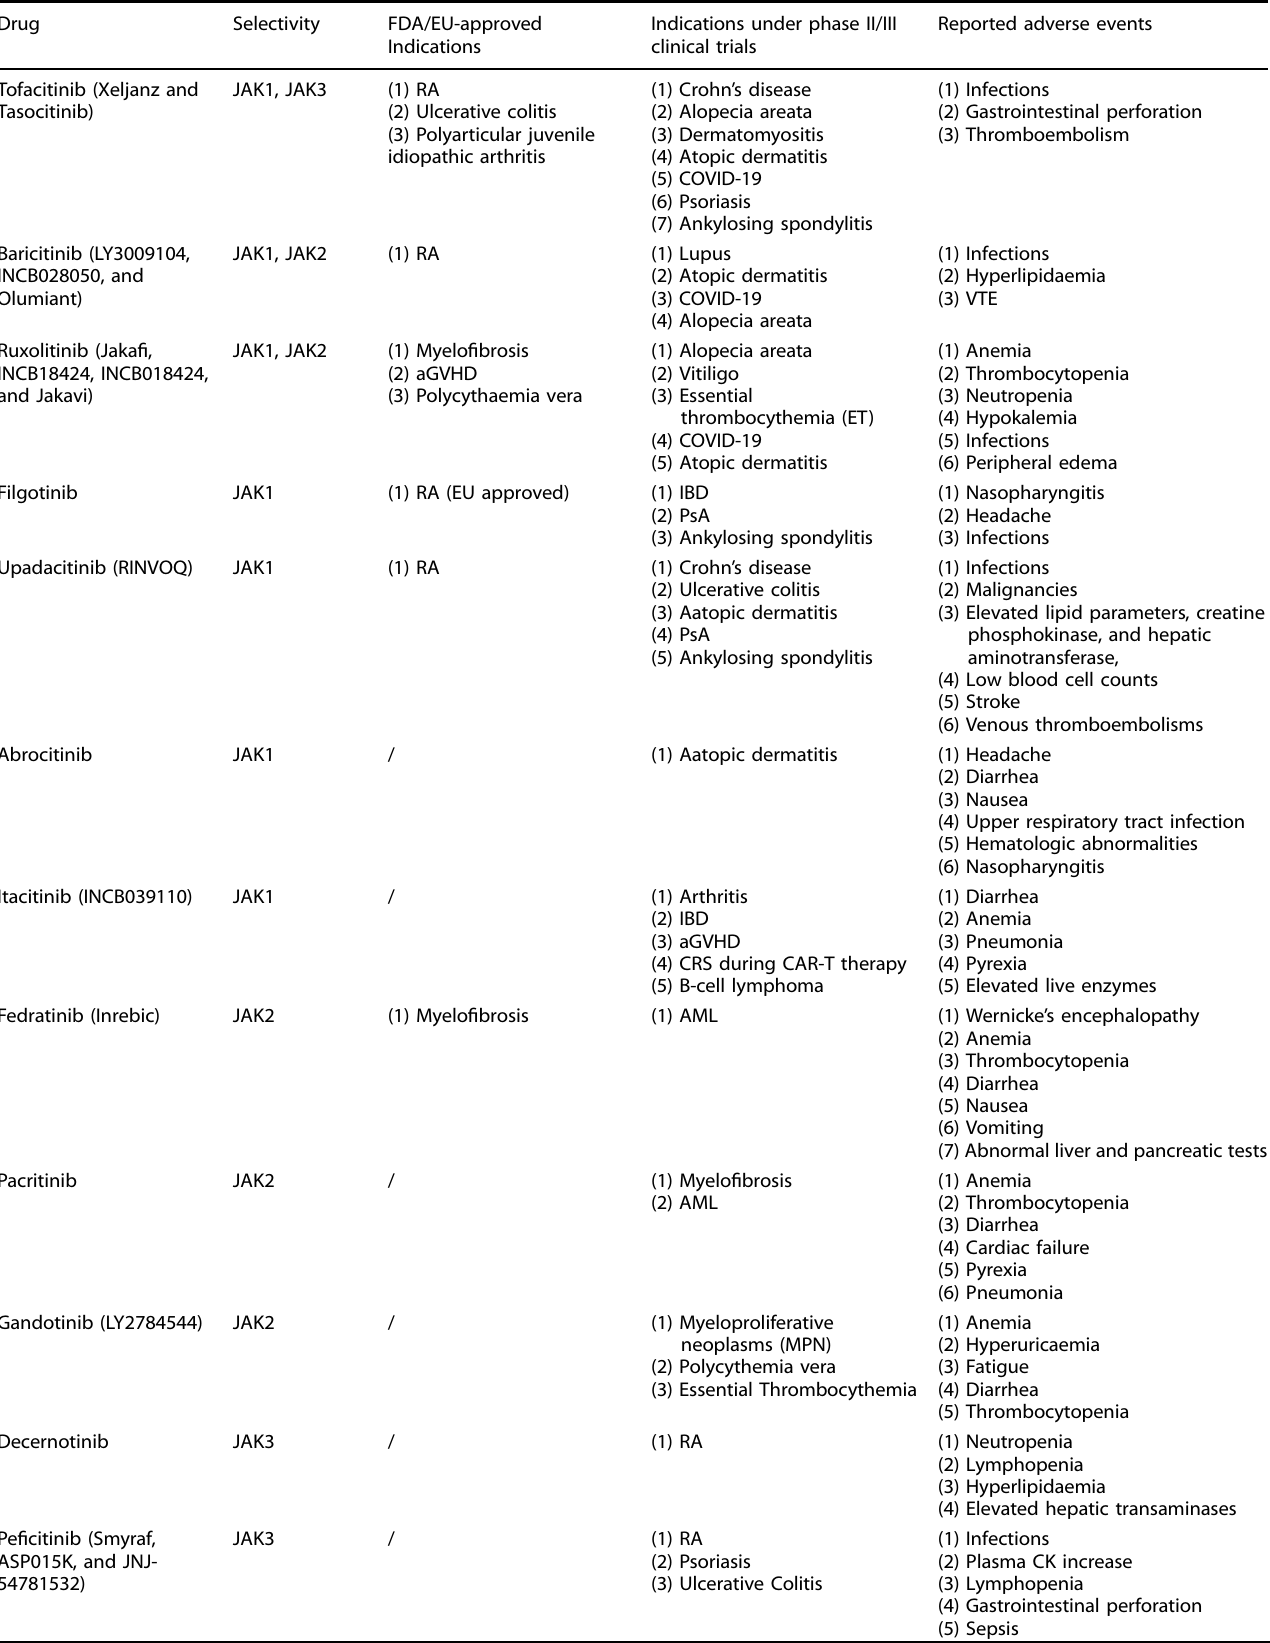
Table 4. Clinical application of JAK inhibitors